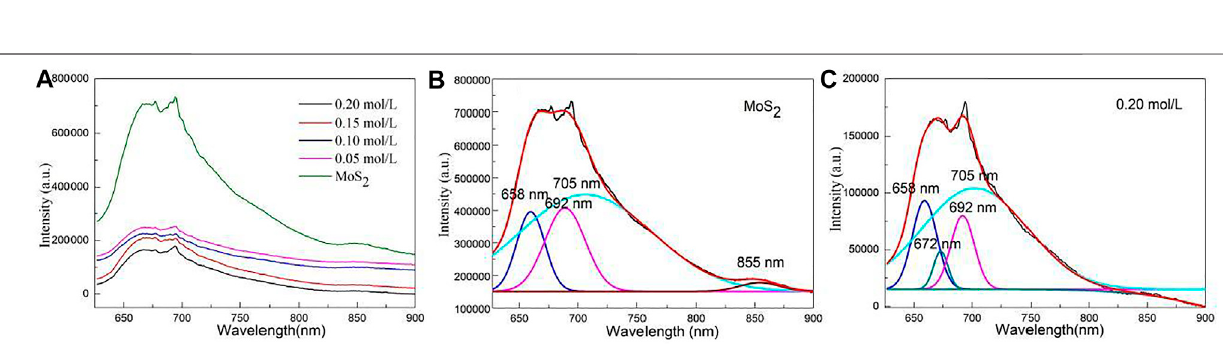
FIGURE 5 | (A) UV – Vis absorption spectra and (B) Eg values of molybdenum disul fi de/biological structure carbon composites prepared by the hydrothermal calcination method with the different concentrations of molybdenum chloride including 0.05, 0.10, 0.15, and 0.20 mol/L.